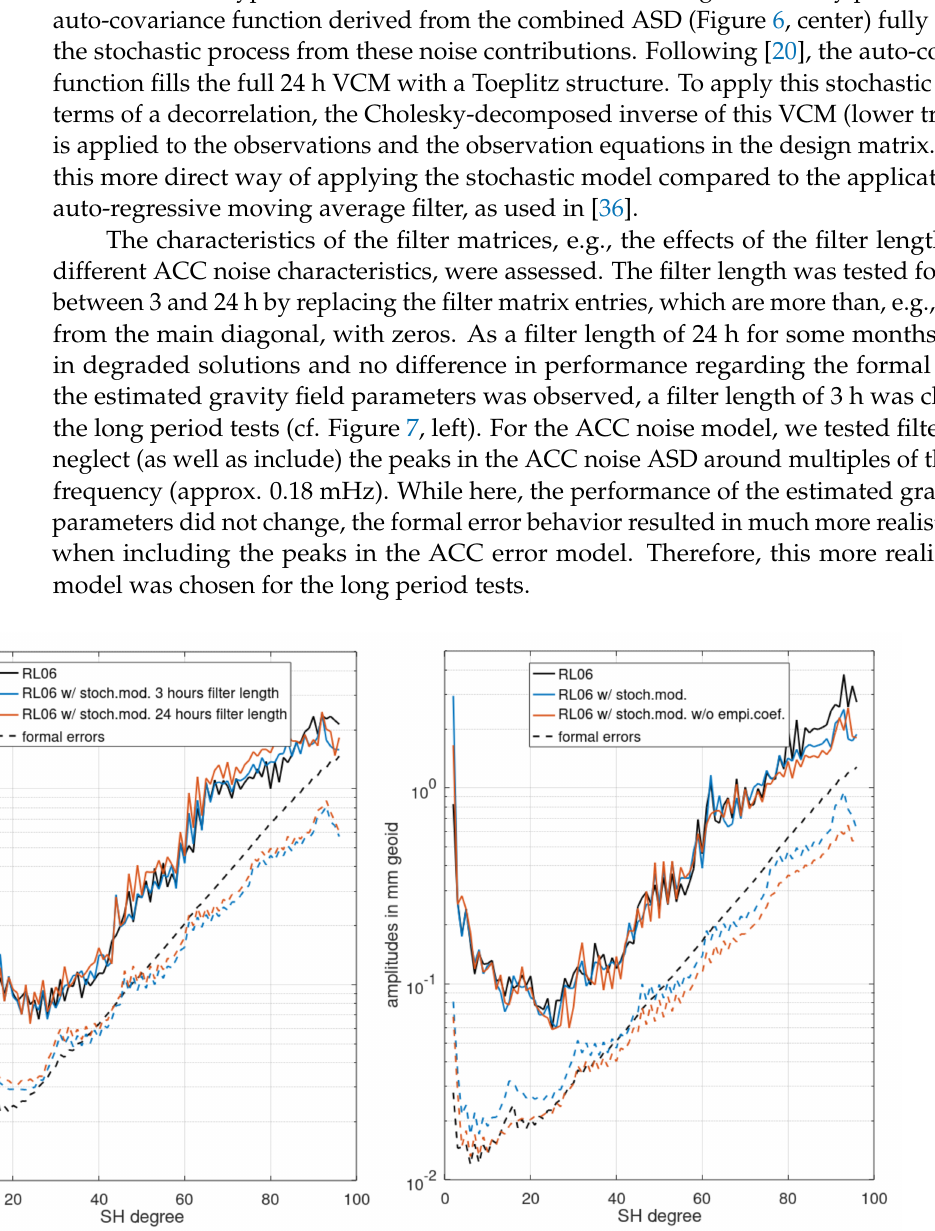
Figure 7. Monthly GRACE solutions for November 2007 ( left ) and January 2007 ( right ) in terms of SH degree amplitudes in mm geoid heights of differences with respect to a GFZ GRACE RL06 climatology model (solid lines), and of formal errors (dashed lines), comparing RL06, RL06 applying stochastic modeling with different filter lengths ( left ), and RL06 with stochastic modeling (3 h filter length) with and without estimating empirical parameters ( right